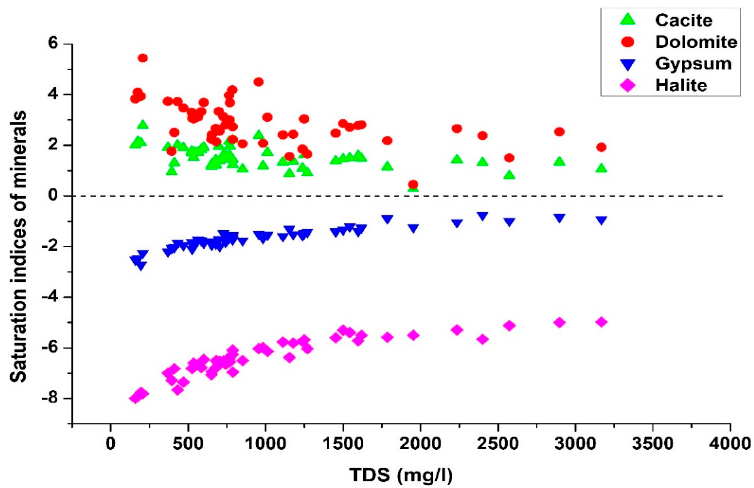
Figure 5. Variation of saturation indices of selected minerals.